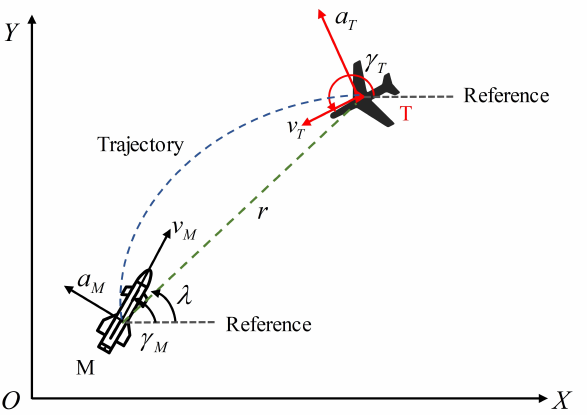
Figure 1. Guidance geometry of missile–hypersonic-vehicle engagement. Based on Figure 1, the relative motion relationship between the missile and hyper- sonic vehicle established in the line-of-sight (LOS) coordinate system can be described as Equations